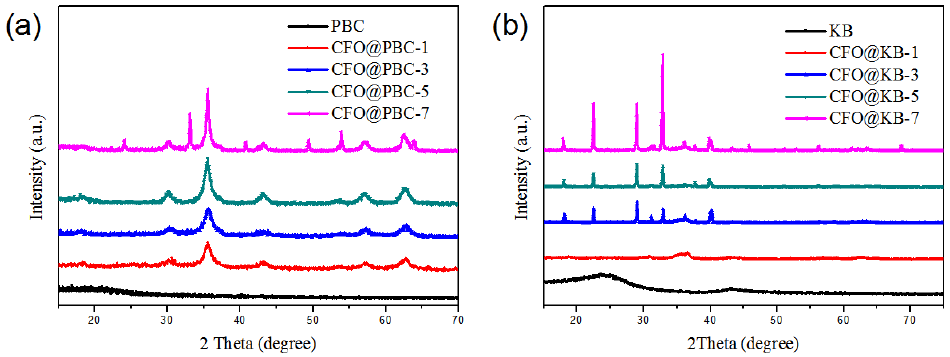
Figure 2. XRD patterns of ( a ) PBC and CFO@PBC samples; ( b ) KB and CFO@KB samples.